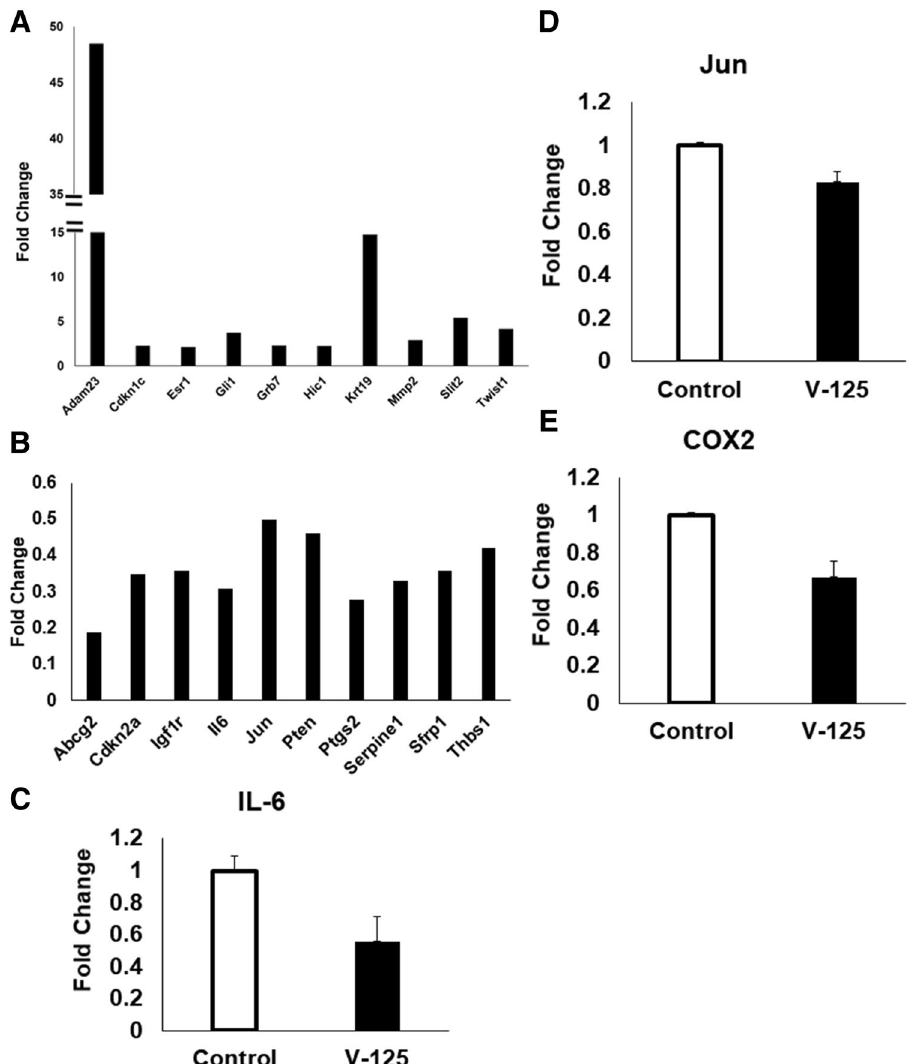
Figure 6. V-125 differentially regulates cancer-associated genes in tumors. Mice with established mammary tumors 5 mm in diameter were treated with control or V-125 (100 mg/kg in diet) for 10 days. Total RNA was extracted for PCR array. Analysis was performed using GeneGlobe software (Qiagen), revealing the upregulation of 10 genes with a log fold change > 2 ( A ), and the downregulation of 10 genes with a log fold change > 2 ( B ). Validation was performed on IL-6 ( C ), Jun ( D ), and COX2 ( E ) by qPCR. N = 2 mice/group. Data shown is representative of two independent experimental